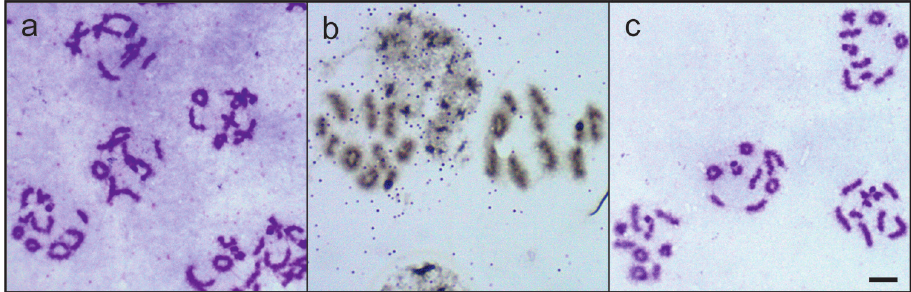
Figure 3. a diplotene–diakinesis in N. plebejus b–c diakinesis–metaphase I b N. bozdagus c N. plebejus . Bar = 5 µm.